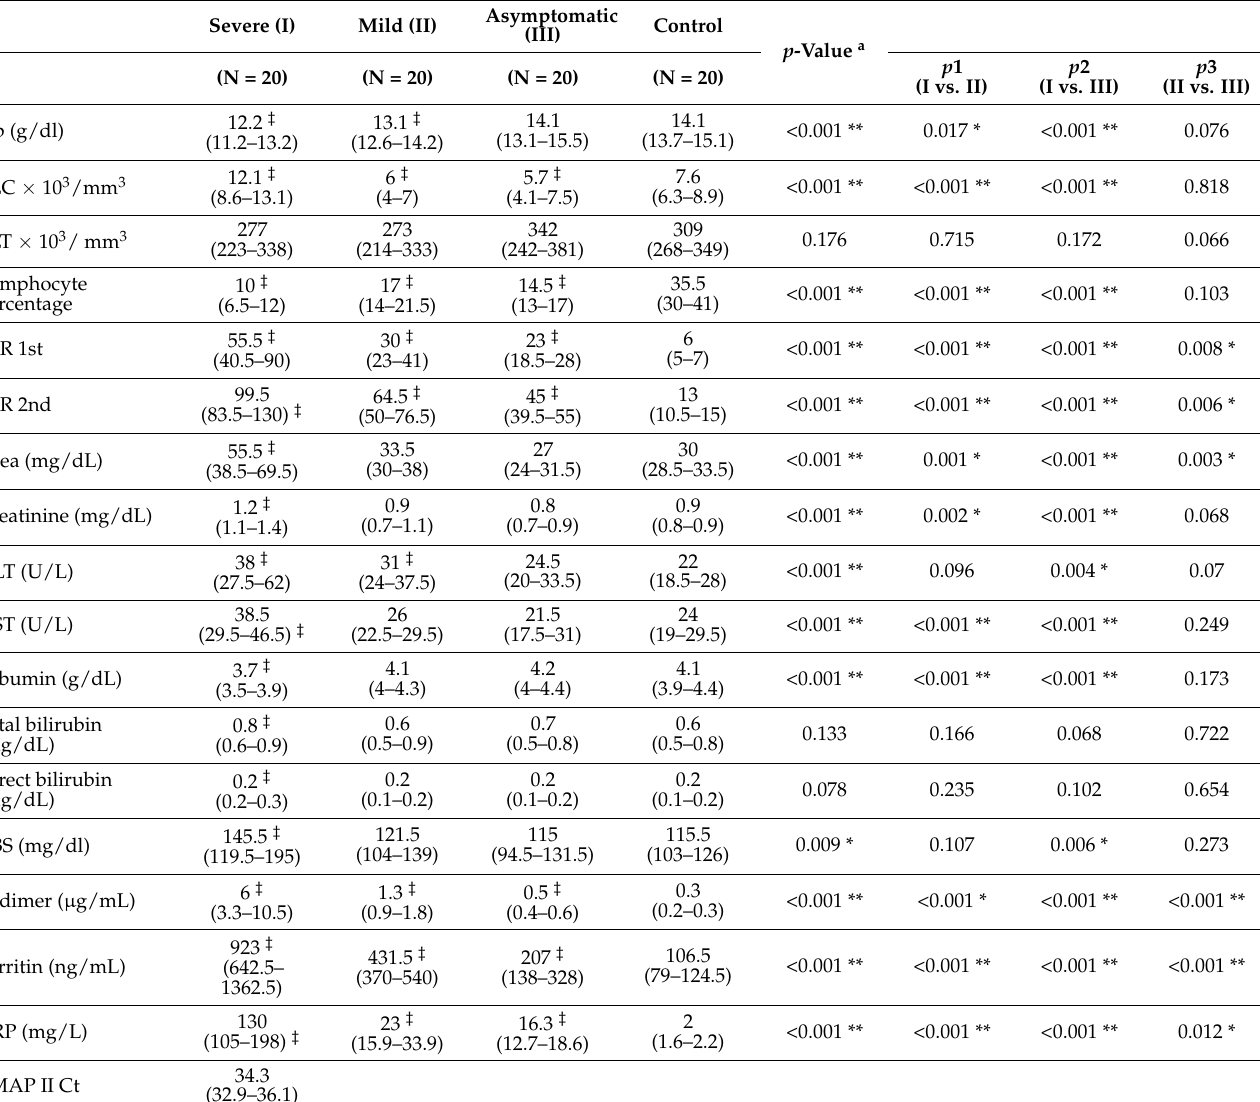
Table 2. Comparison of laboratory criteria and EMAP II Ct in the studied